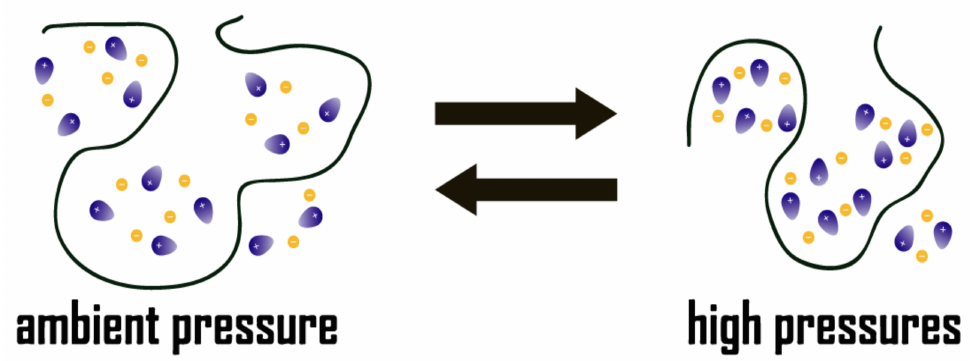
Figure 10. Illustration of the possible structural reorganization of [HMIM]Br-PEO